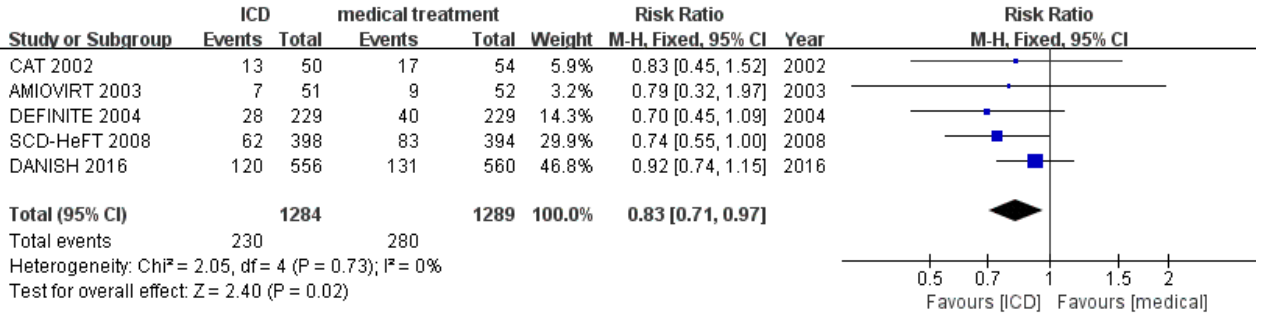
ACE/ARB=angiotensin-converting enzyme inhibitor/angiotensin receptor blocker; AMIOVIRT=Amiodarone vs. Implantable Defibrillator Randomized Trial; CAT=cardiomyopathy Trial; DANISH=Danish Study; DEFINITE=Defibrillators in non-Ischemic cardiomyopathy treatment evaluation; LVEF=left ventricular ejection fraction; NYHA=New York Heart Association; SCD-HeFT=Sudden Cardiac Death in Heart Failure Trial